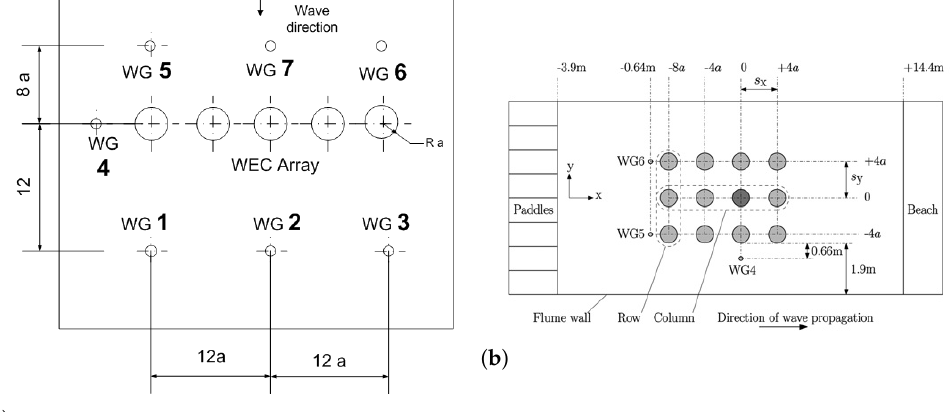
Figure 3. Wave flume of Manchester University’ WEC array layout ( a ) used by Alexandre et al., reprinted with permission from Ref. [32], 2009, Alexandre et al. and ( b ) used by Weller et al., reprinted with permission from Ref. [33], 2010, Weller et